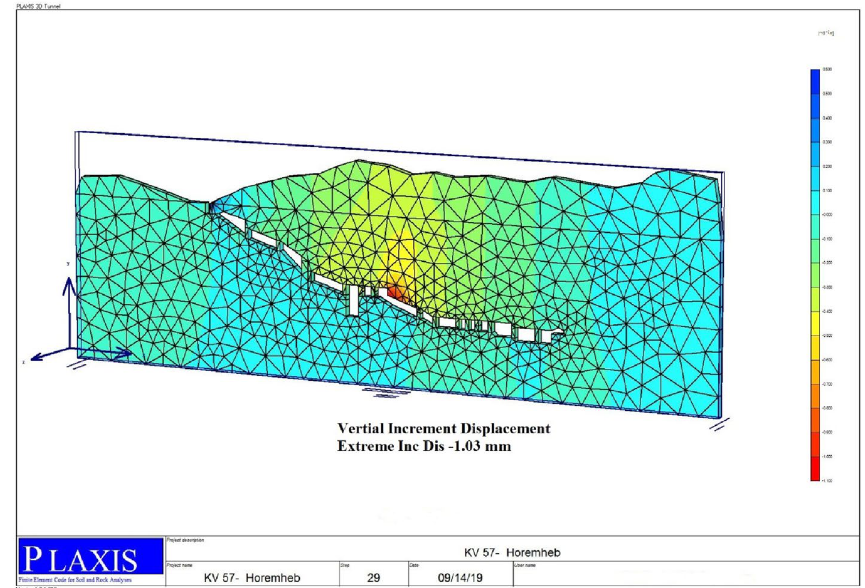
Fig. 7. Vertical Incremental displacement, the extreme value is 1.03